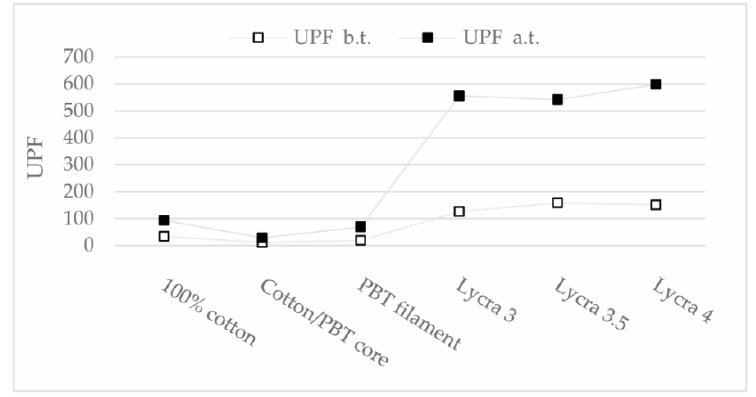
Figure 6. UPF of samples before (b.t.) and after (a.t.) treatment. According to the results, PBT filament yarns have a great potential for the production Raw fabrics containing Lycra in the weft stretched to an areal density of 310 g/m of lightweight elastic fabrics. Not to mention the fact that PBT has better resistance to fin- ishing processes and better durability than elastane.